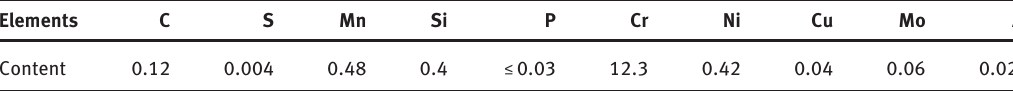
Table 1: Main chemical composition of the AISI 410 used in the experiments (mass%). Elements